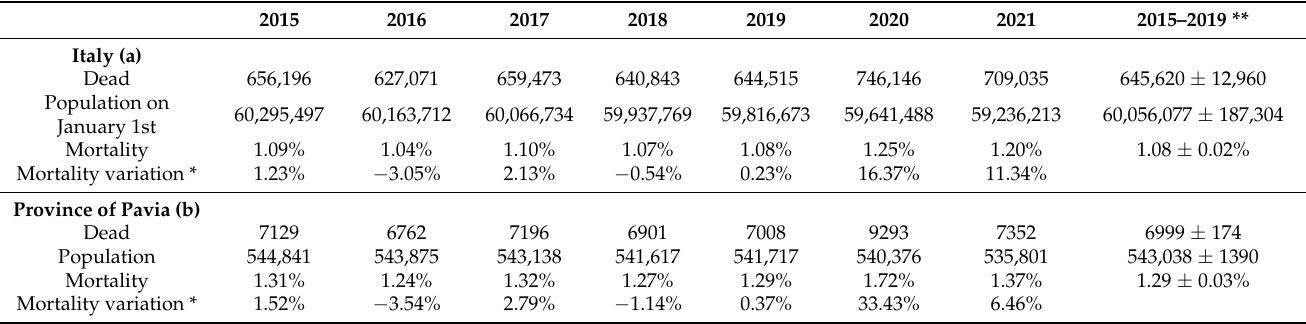
Table 2. Death-related data on the Italian population, the resident population of the province of Pavia, and those enrolled in the provincial registry of physicians and